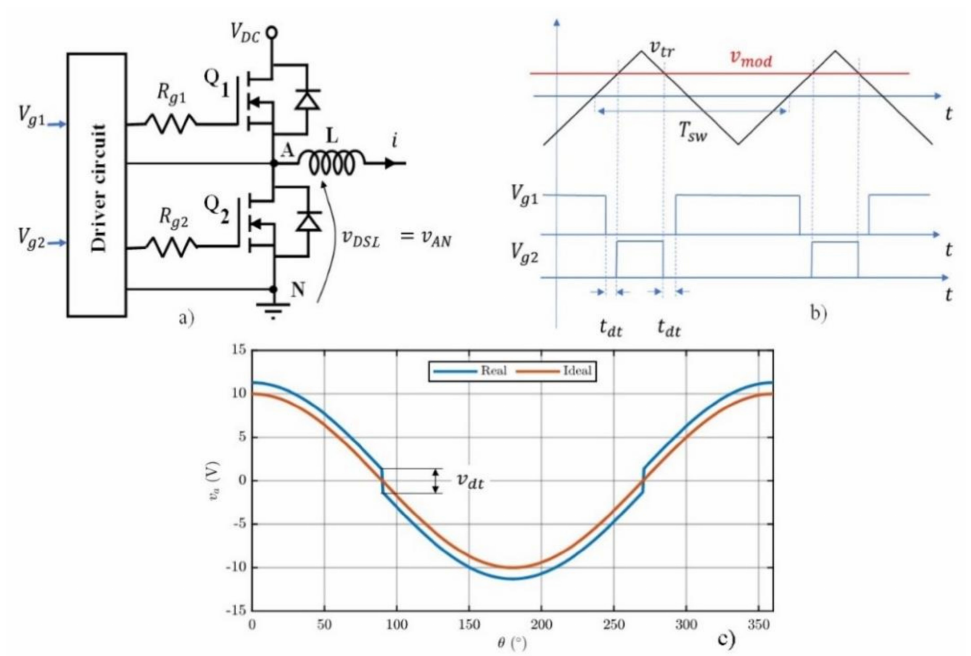
Figure 15. ( a ) Simplified inverter switching leg schematic. ( b ) Phase A, control signal generation by PWM technique with dead time. ( c ) Dead time effect on the moving average value of the inverter output voltage.